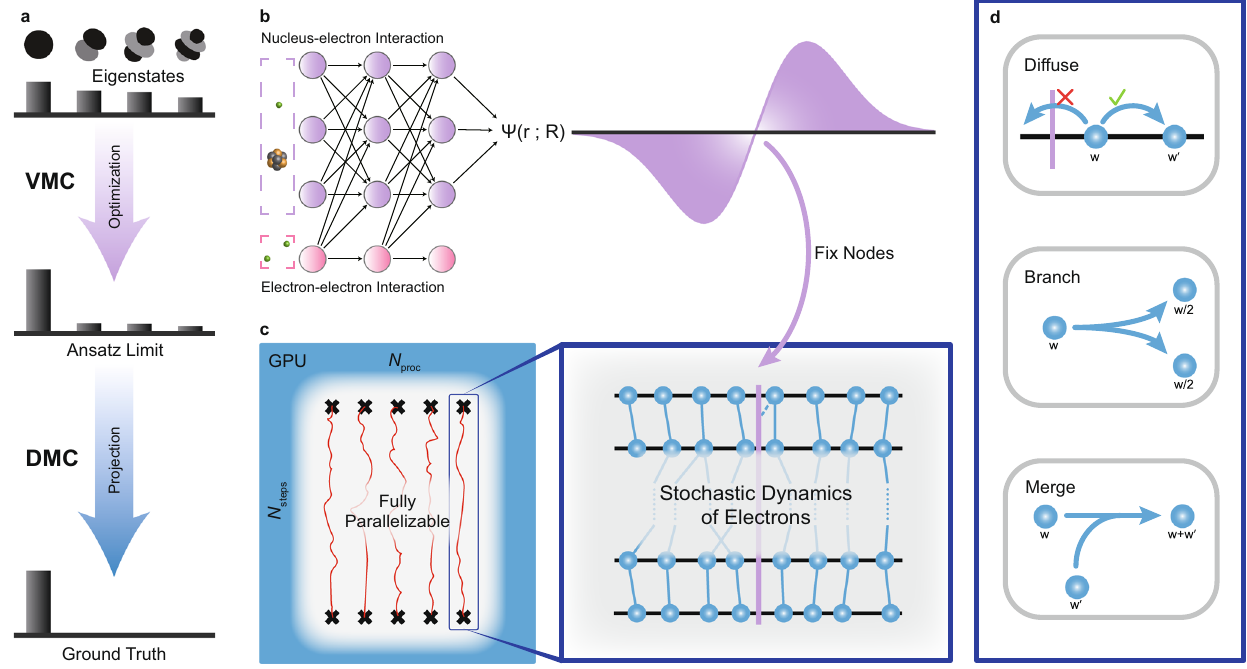
Fig. 1 | Computational framework. a A sketch of a brief overview on variational Monte Carlo (VMC) and diffusion Monte Carlo (DMC) from the perspective of eigenstates composition. Atomic orbitals represent different eigenstates, and histogramsindicatetheweightofeacheigenstateinthestatedecomposition.Top: Arandomlyinitializedstatewithnodominanteigenstate.Middle:Theoutputstate of VMC where the ground state dominates, but other eigenstates are still non- negligible due to ansatz limitations. Bottom: The output state of DMC, which surpassesansatzlimitationsandreachesthegroundstate. b Left:aneuralnetwork ansatz of wavefunction; right: one dimensional projection of a many-electron wavefunction and its nodal surface. c Left: parallelized diffusion Monte Carlo